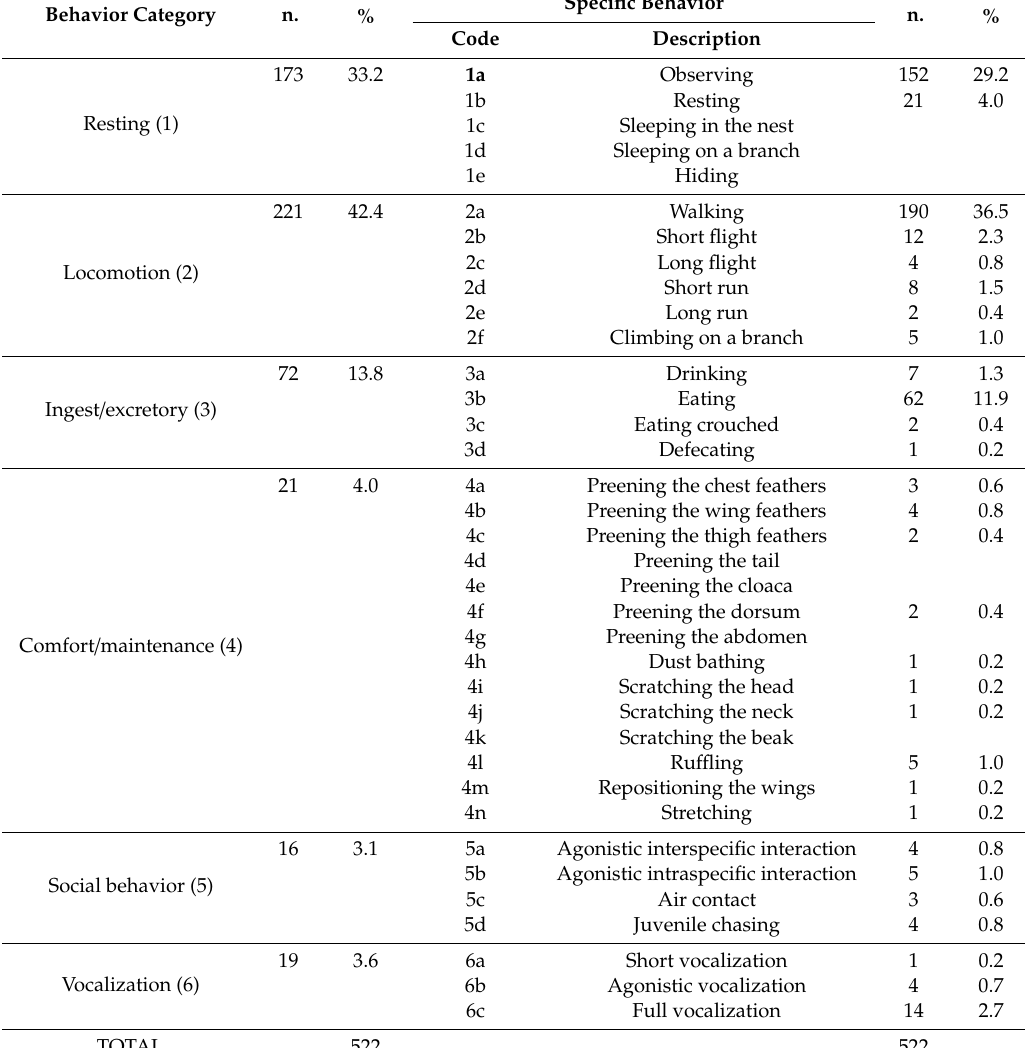
Table 2. Quantification of the occurrence of each natural behavior of the Red-legged Seriema in the study area. Behaviors follow Silva et al. [32] where more details on each behavior may be obtained.